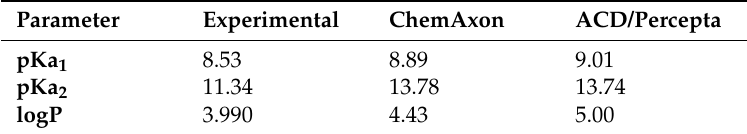
Table 3. Experimental and computer estimated pKa and logP values of compound 3e.